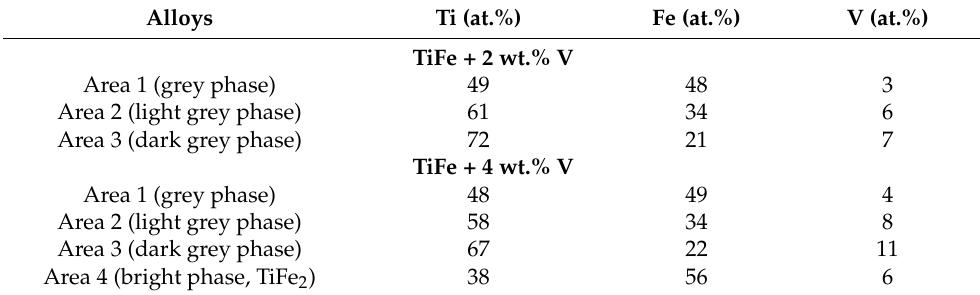
The micrograph of the alloy with the addition of 2 wt.% Zr + 2 wt.% V is shown in Figure 3. Here, four different regions could be identified: (1) grey phase, (2) light grey phase, (3) bright phase and (4) dark grey phase. The chemical composition of each phase is listed in Table 3. The grey phase has the composition of TiFe with ~2 at.% of V, but Zr is absent in this phase. As for the preceding system, the light grey phase seems to have a Ti 2 Fe-type composition, but here, vanadium and zirconium seem to substitute for titanium, giving a (Ti,V,Zr) 2 Fe composition. The bright phase is the phase with the highest proportion of zirconium. It should be noted that this phase is at the edge between the grey phase and light grey phase. Moreover, the composition is close to the light grey phase except for the higher proportion of Zr. The dark grey phase is Ti-rich. The average grain size of each phase was calculated by Image J software using the 100 µ m scale back-scattered micrograph [28]. For 2 wt% V, the estimated average grain size of the TiFe phase is 71 ± 1 µ m. For the secondary Ti 2 Fe-type and Ti-rich phases, the average grain sizes are, respectively, 11 ± 1 µ m and 12 ± 1 µ m. In the case of the 4 wt% V, the average grain sizes of TiFe, Ti 2 Fe-type, Ti and TiFe 2 phases are, respectively, 72 ± 2 µ m, 7 ± 1 µ m, 8 ± 1 µ m and 36 ± 1 µm.